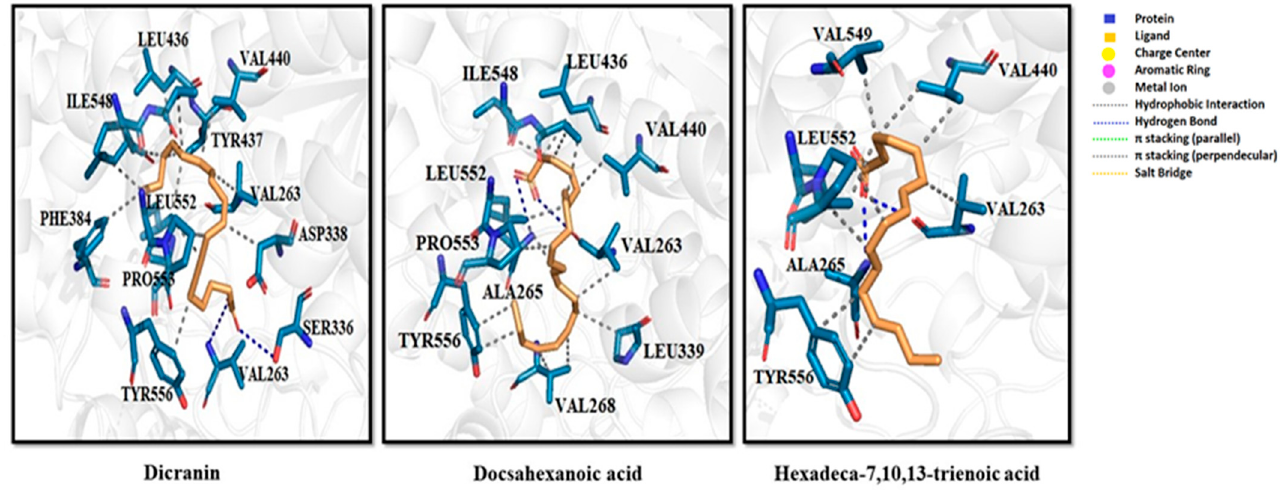
Figure 10. Protein–ligand interactions using PLIP server. Protein–ligand interactions of dicranin, docosahexanoic acid, and hexadeca-7,10,13-trienoic acid with B. cinerea lipase are represented, highlighting the key residues involved in the interaction.